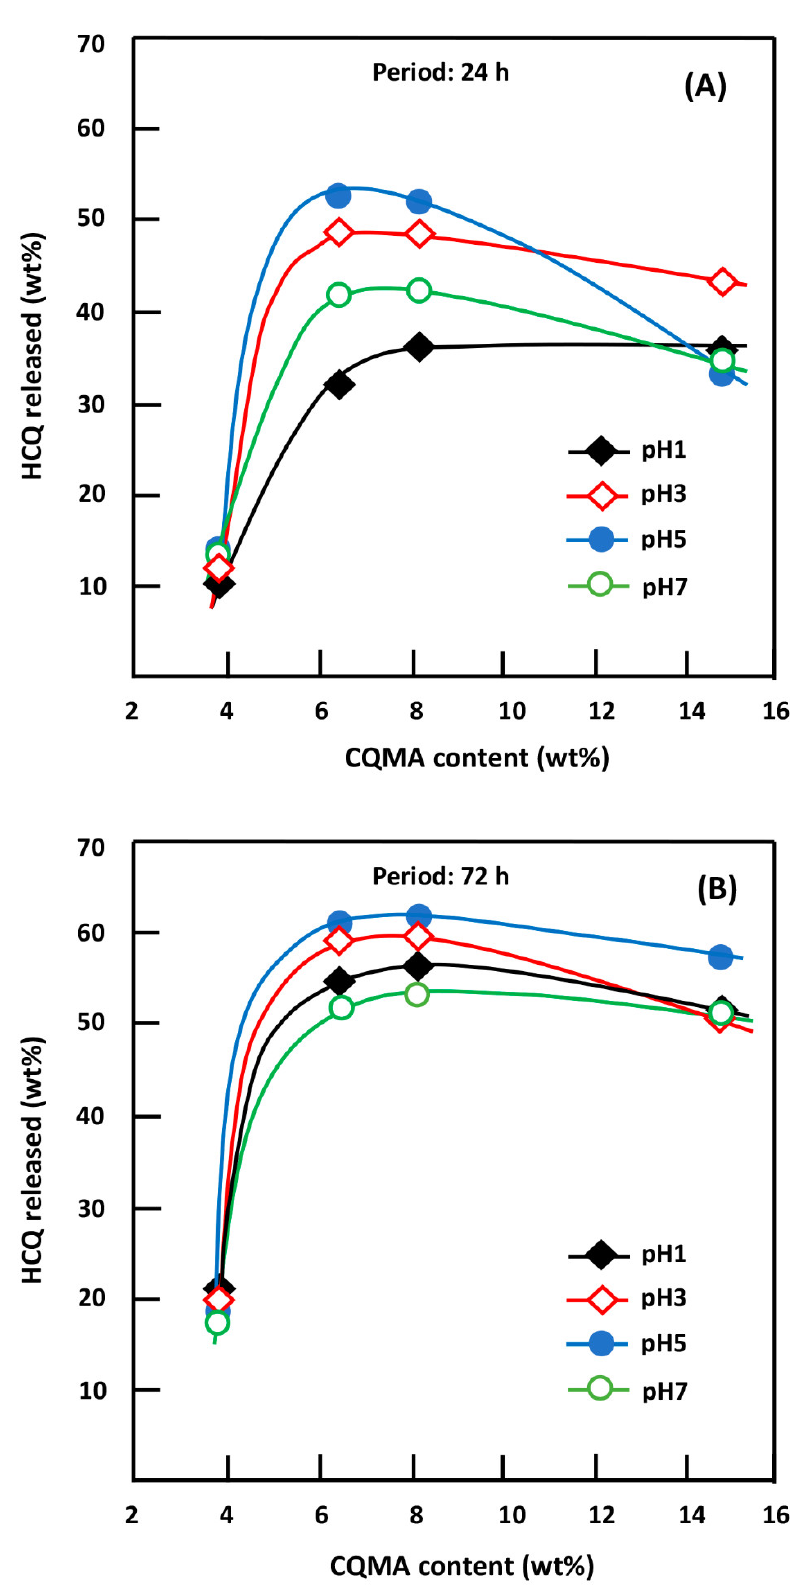
Figure 18. Variation of the HCQ released during 24 h ( A ) and 72 h ( B ) of the release process versus the CQMA content in the drug carrier system and in different media pHs.